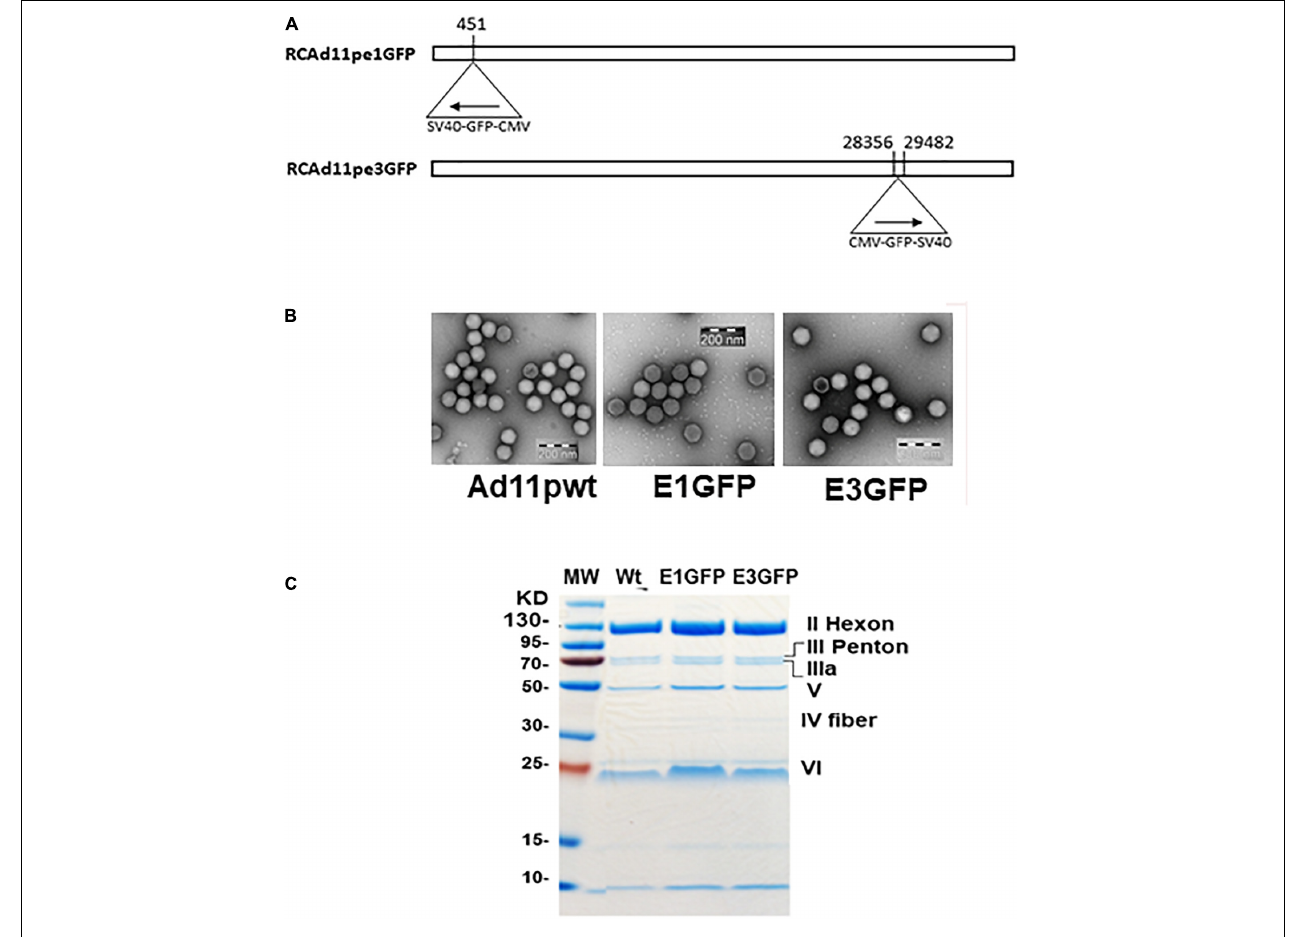
FIGURE 2 | (A) Strategy for the development of replication-competent Ad11p containing the GFP gene in early regions 1 and 3 (RCAd11pe1GFP and RCAd11pe3GFP). (B) Electron microscopy images of virus particles. (C) Viral protein analysis using SDS-PAGE and Coomassie brilliant blue staining.